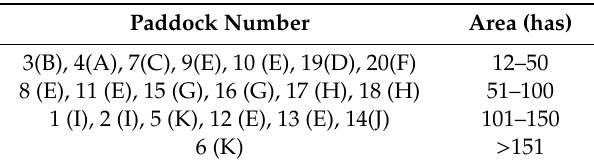
Table 1. Area of the 20 paddocks analyzed in this study. Paddocks were designated from 1 to 20. Letters from A to K designate